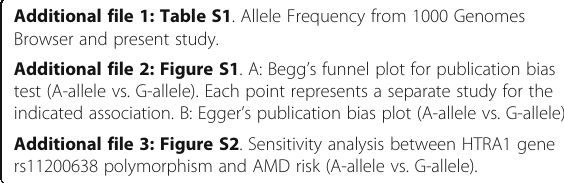
Additional file 1: Table S1 . Allele Frequency from 1000 Genomes Browser and present study. Additional file 2: Figure S1 . A: Begg ’ s funnel plot for publication bias test (A-allele vs. G-allele). Each point represents a separate study for the indicated association. B: Egger ’ s publication bias plot (A-allele vs. G-allele). Additional file 3: Figure S2 . Sensitivity analysis between HTRA1 gene rs11200638 polymorphism and AMD risk (A-allele vs.